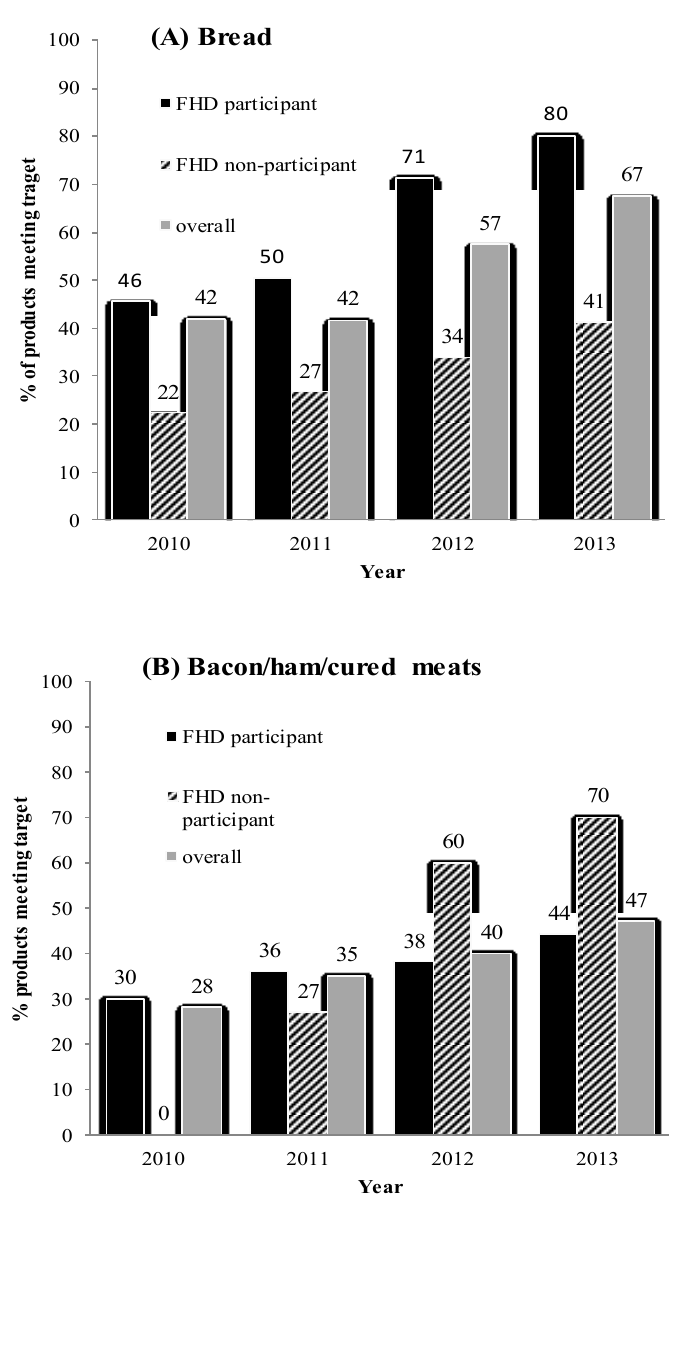
Figure 1. The proportion of products that met the respective Food and Health Dialogue (FHD) target by FHD participant status and overall for ( A ) bread, ( B ) bacon/ham/cured meats. For clarity, the exact percentages are shown for each bar.